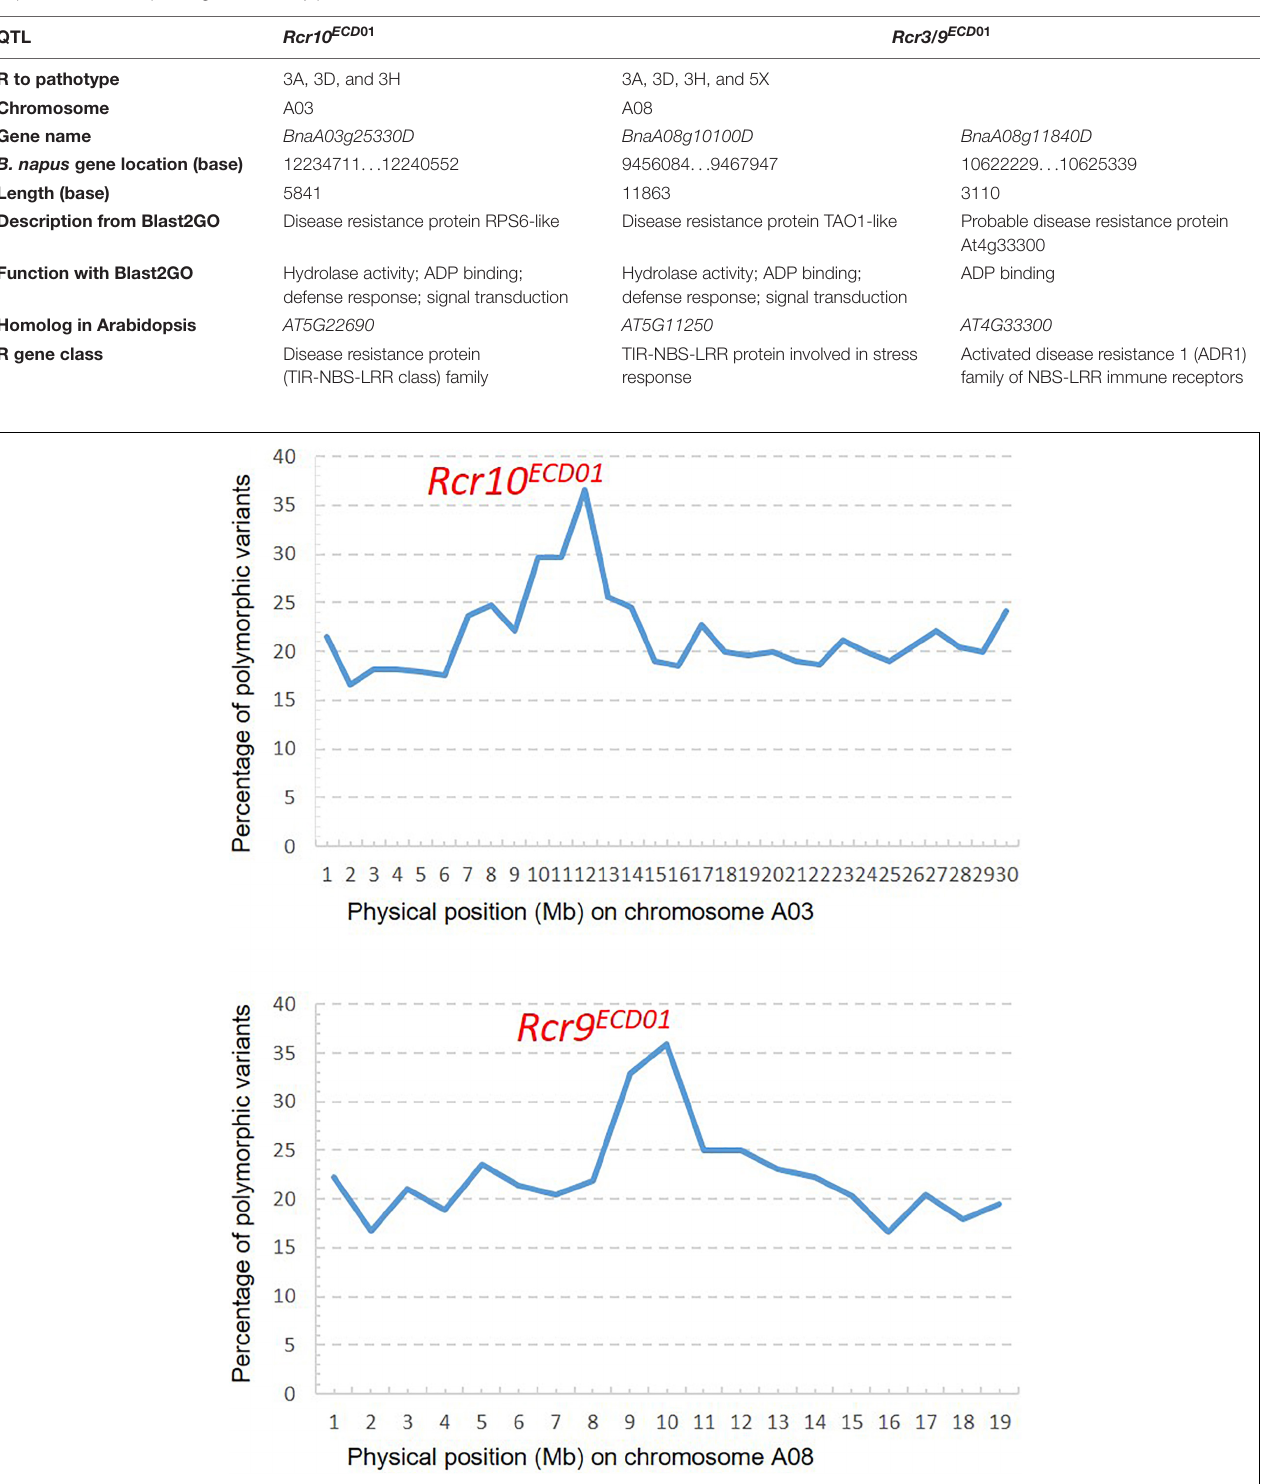
TABLE 4 | A list of genes encoding proteins associated with plant disease resistance through BLAST2GO and Blast searches with CDS in the QTL target regions at https://www.arabidopsis.org/Blast/index.jsp. QTL Rcr10 ECD 01 Rcr3/9 ECD 01